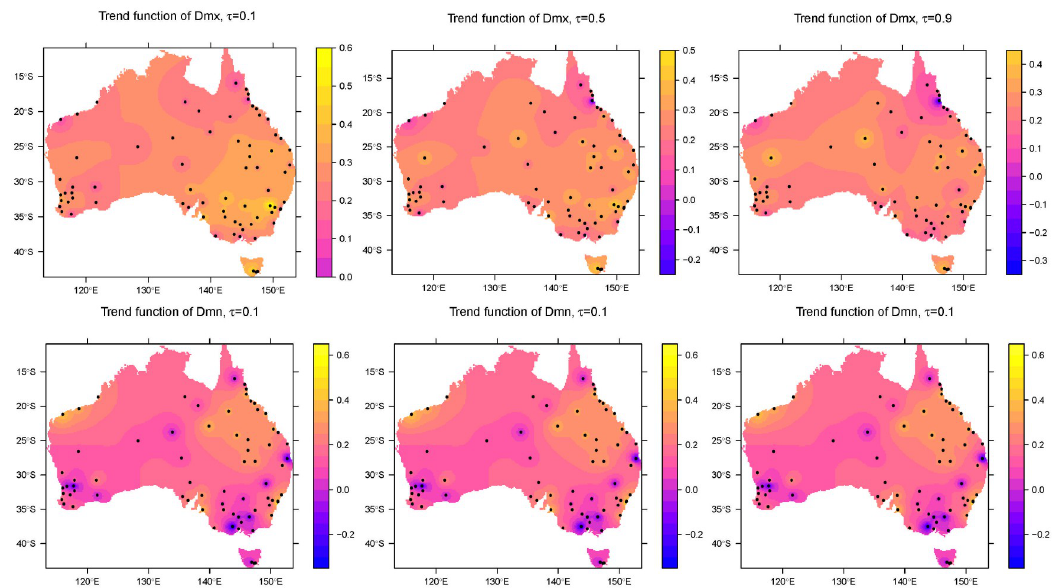
Fig 5. Quantile trend of τ = 0.1, 0.5 and 0.9 for overall Australia during the study period. The color of point is the total degrees Celsius that increased/decreased per decade from 1960 to 2019. The top panels are for the Dmx series and the bottom panels are for the Dmn